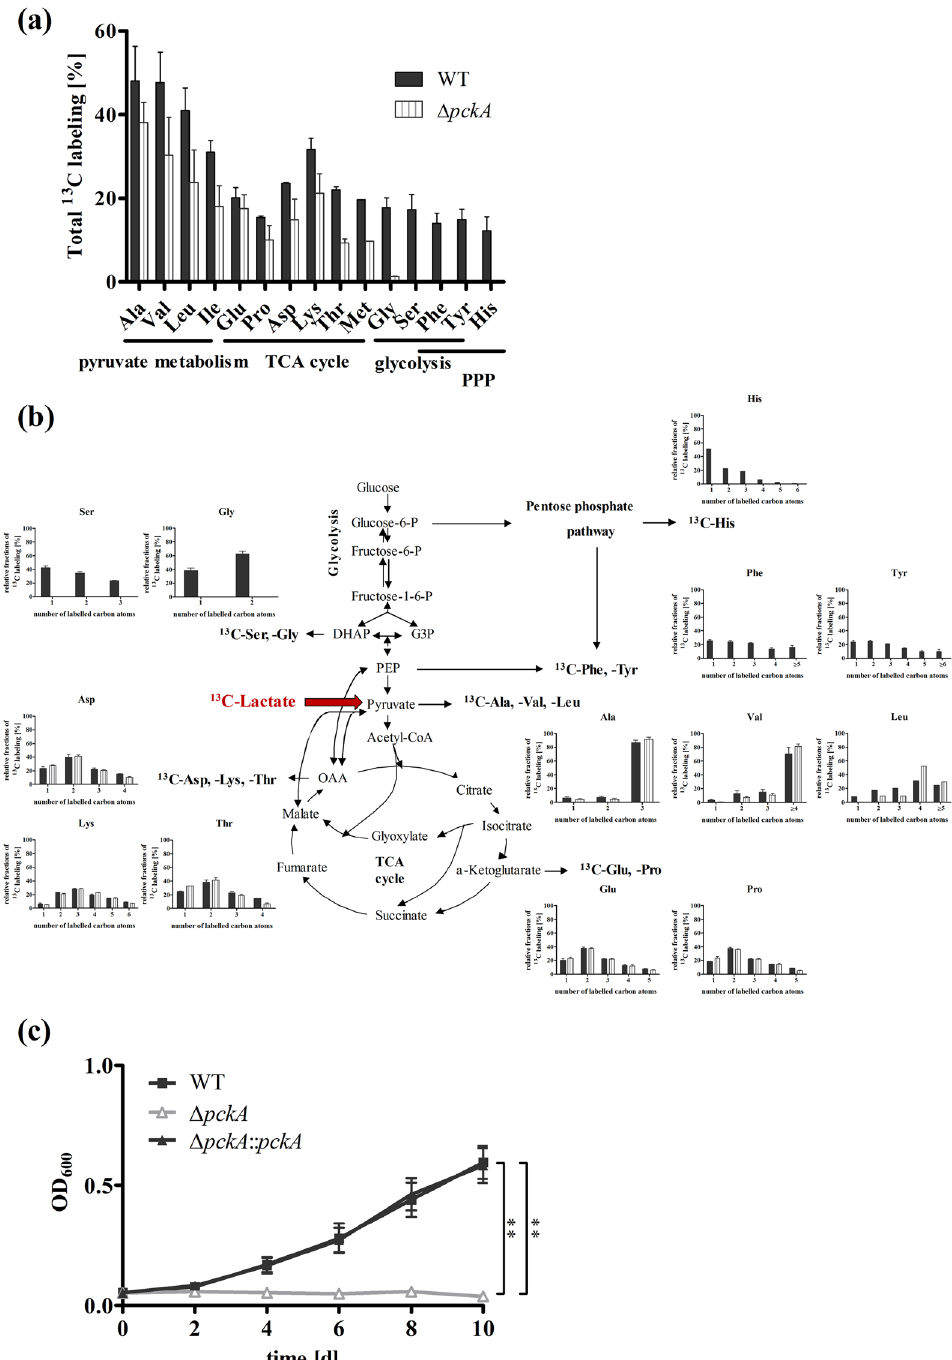
Figure 4. Comparison of lactate derived 13 C-carbon flux in Mtb wild type and the ∆ pckA mutant with a defect in gluconeogenesis, and growth of the ∆ pckA mutant on lactate. To characterize the lactate derived carbon flux in Mtb , the Mtb Erdman wild type strain (black bars) and the ∆ pckA mutant (striped bars) were grown for two days in medium containing 10 mM glucose and 10 mM [U- 13 C 3 ]-L-lactate. Labelling patterns in amino acids were detected by GC/MS analysis. The overall 13 C-enrichments are depicted in ( a ). The relative fractions (%, y-axis) of 13 C-labelled isotopologues of the wild type strain (black bars) and the ∆ pckA mutant (striped bars) with a given number of 13 C-atoms (x-axis) are shown in ( b ). Data represent the mean of two independent experiments each measured in technical triplicates; error bars indicate the SEM. ( c ) To determine the impact of phosphoenolpyruvate decarboxykinase (PckA) activity on lactate utilization, growth of Mtb Erdman wild-type (black squares), the ∆ pckA mutant (grey triangles) and the complemented strain (black triangles) was measured for 10 days in the presence of L-lactate as sole carbon substrate. The influence of impaired gluconeogenesis on growth was measured via optical density at the indicated time points. Data represent the mean of three independent experiments; error bars indicate the